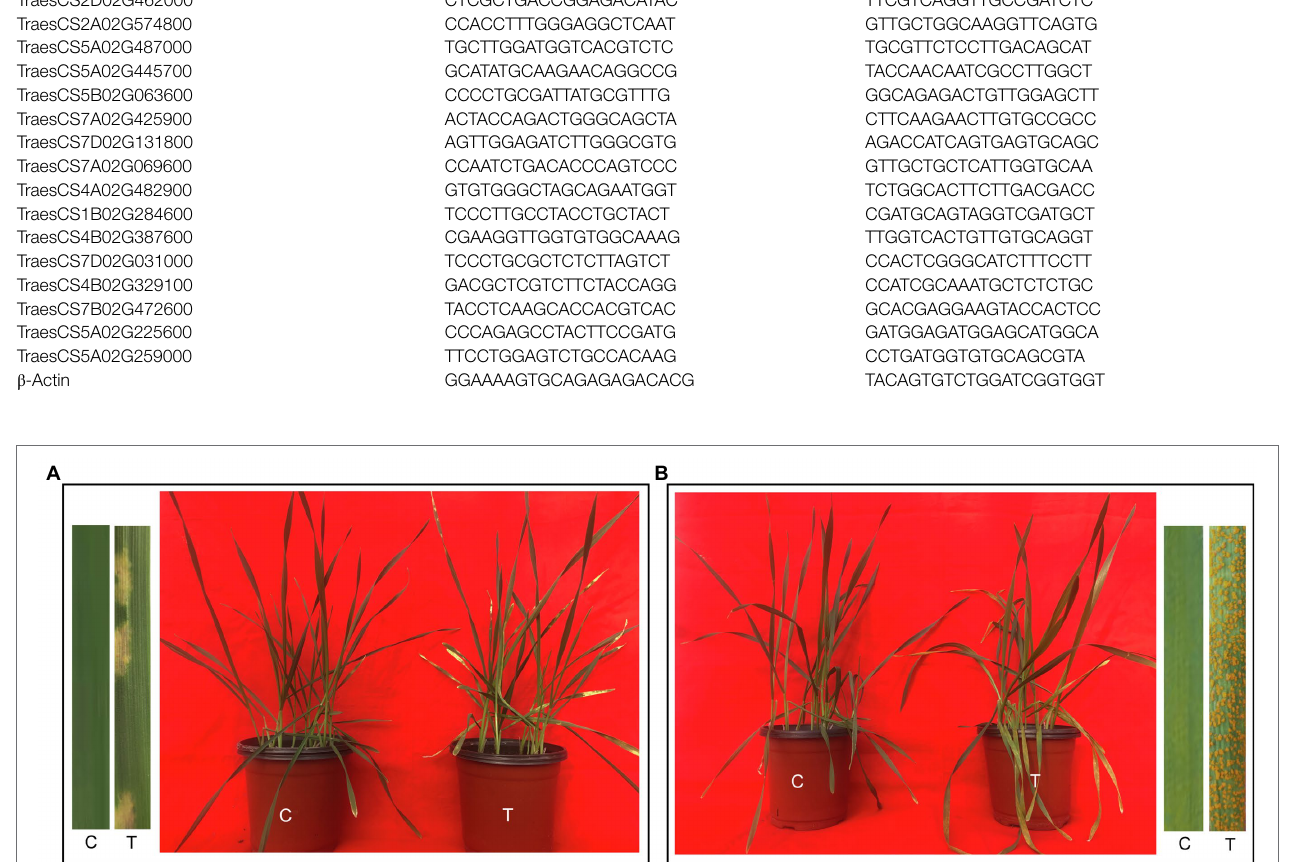
FIGURE 1 | Phenotypes of triticale cultivars Gannong 2 and Shida 1 at 15 days after inoculation with Pst race CYR34. (A,B) Responses of untreated and treated seedlings of Gannong 2 (A) and Shida 1 (B) . C, untreated control; T,